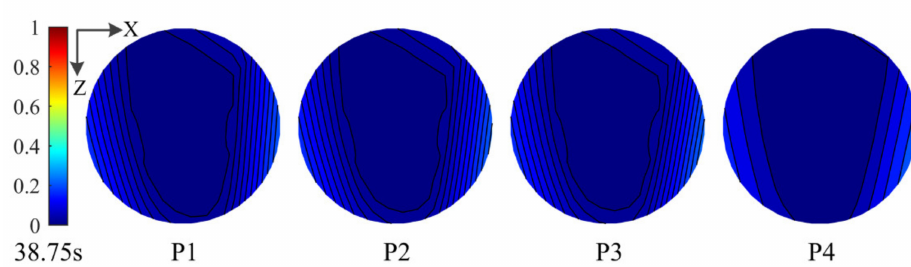
Figure 19. The compression damage of concrete in the core area at 38.75 s.